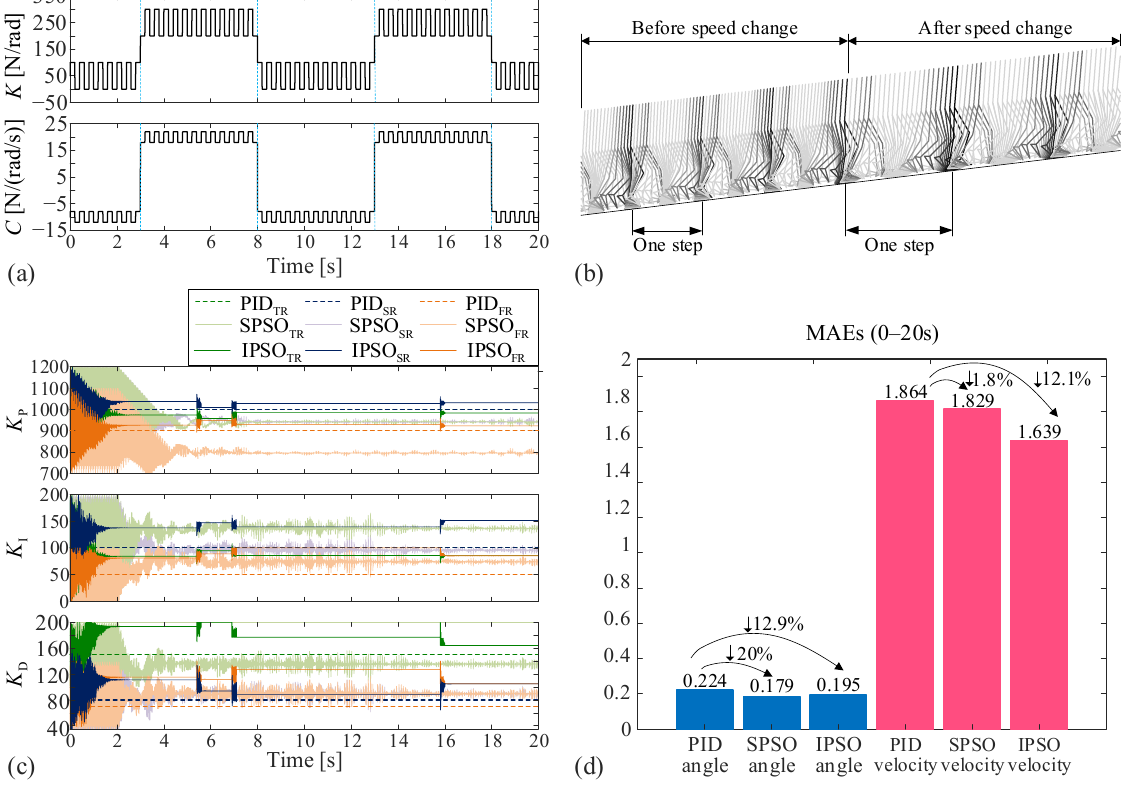
Figure 7. Tracking results of Case IV. ( a ) Fast and slow variations of the stiffness and damping of the exoskeleton joints. ( b ) Stroboscopic view of dynamic walking in upslope with variable speed. ( c ) Evolutions of the PID gains corresponding to the SPSO and the IPSO algorithms; for reference, the pre ‐ tuned PID gains are also plotted. ( d ) Mean accumulated errors (MAEs) in the whole process (0–20s). The reductions brought by the SPSO and the IPSO algorithms are denoted.